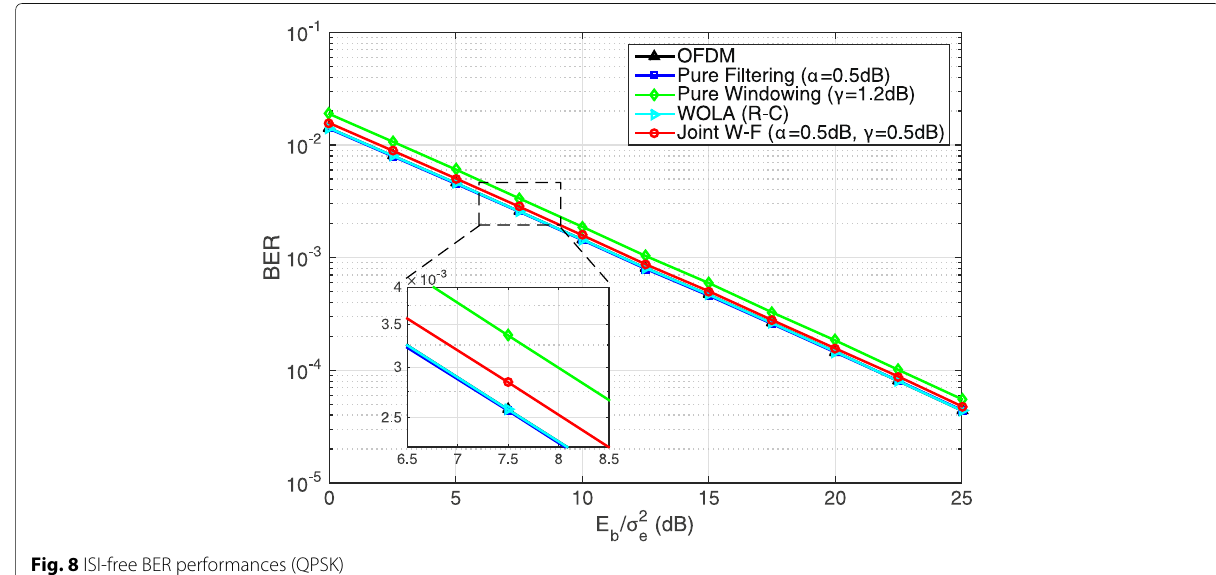
5.8 Asynchronous multi-user BER simulations Here, BER simulations are performed based on an asyn- chronous uplink scenario with multiple users modulated by the same waveform. The proposed waveform has the best performance especially in this scenario.